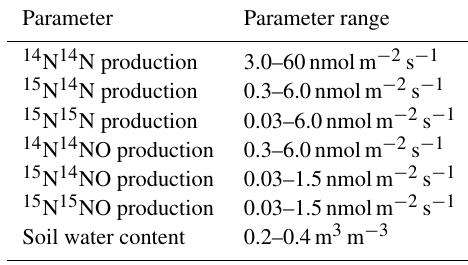
Table 2. Range of parameter values used to assess effect of soil gas transport and production